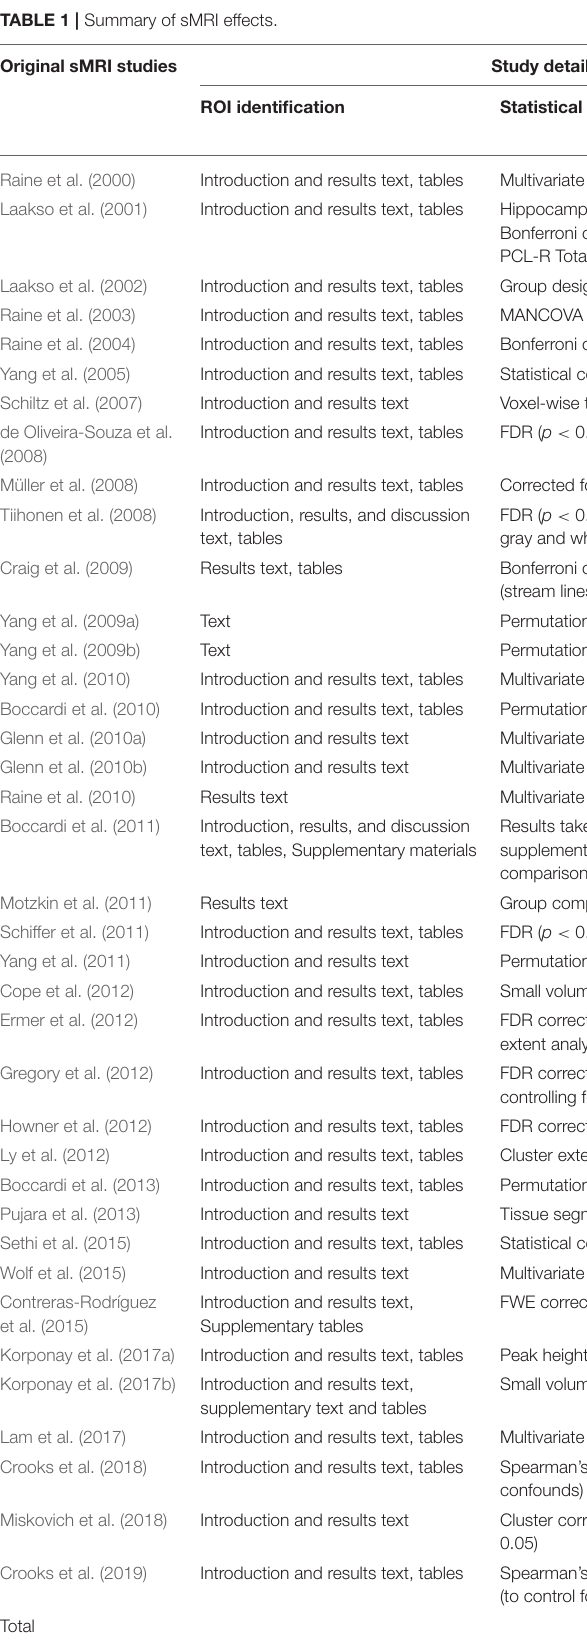
TABLE 1 | Summary of sMRI